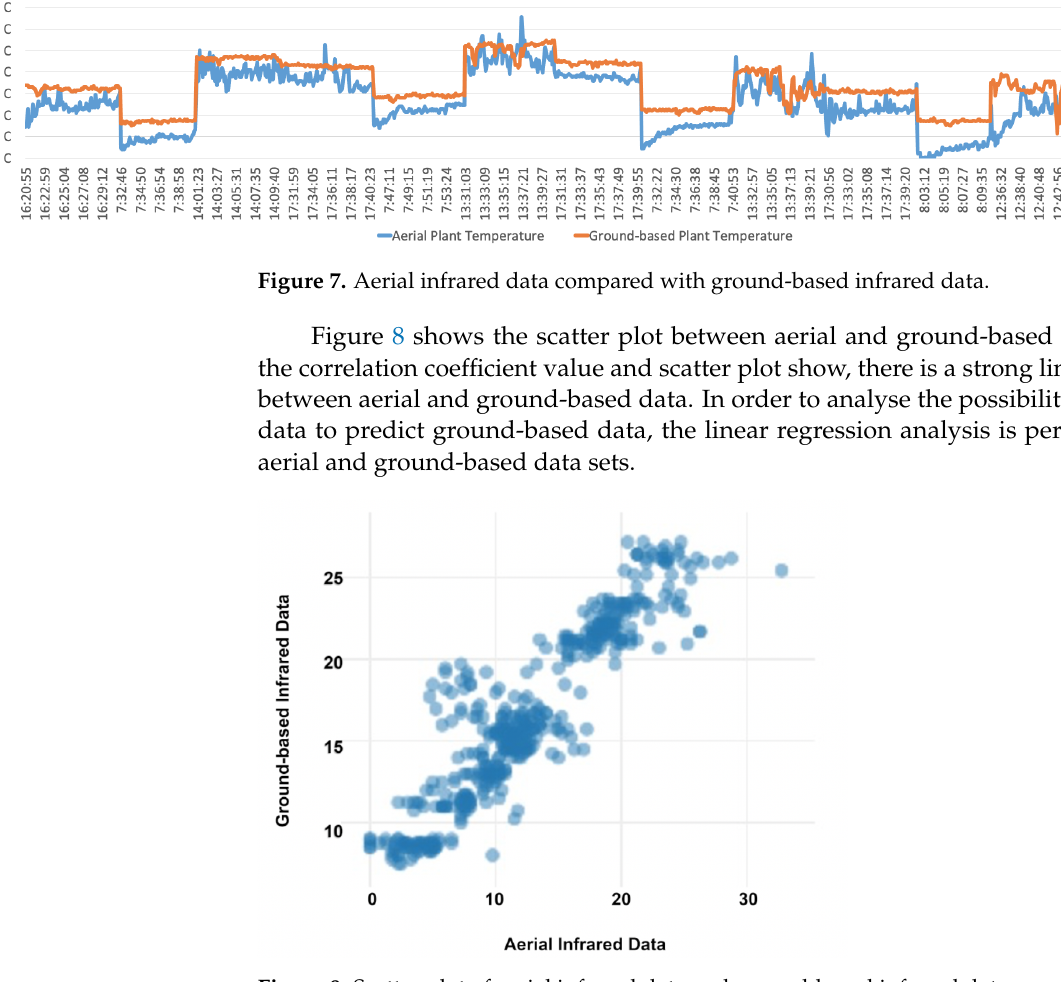
Figure 8. Scatter plot of aerial infrared data and ground-based infrared data.